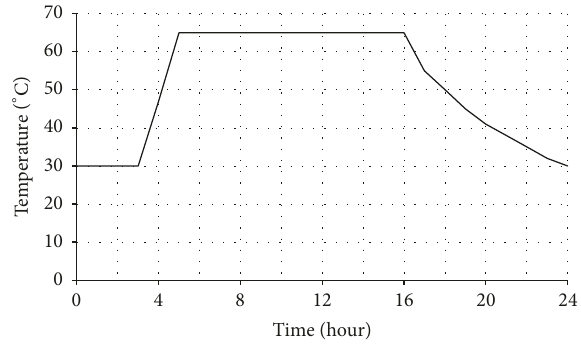
Figure 2: Steam curing